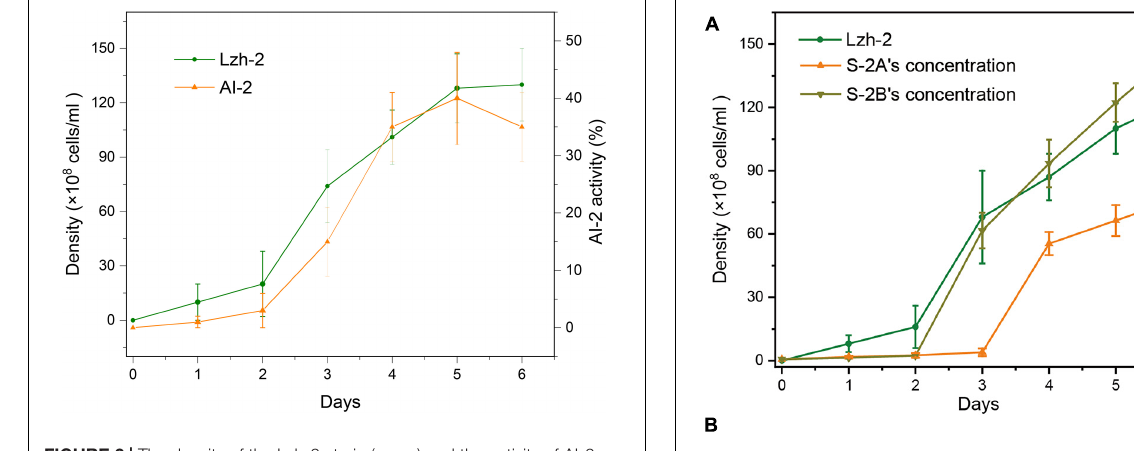
The complete genome was obtained with a total length of 4.6 Mbp